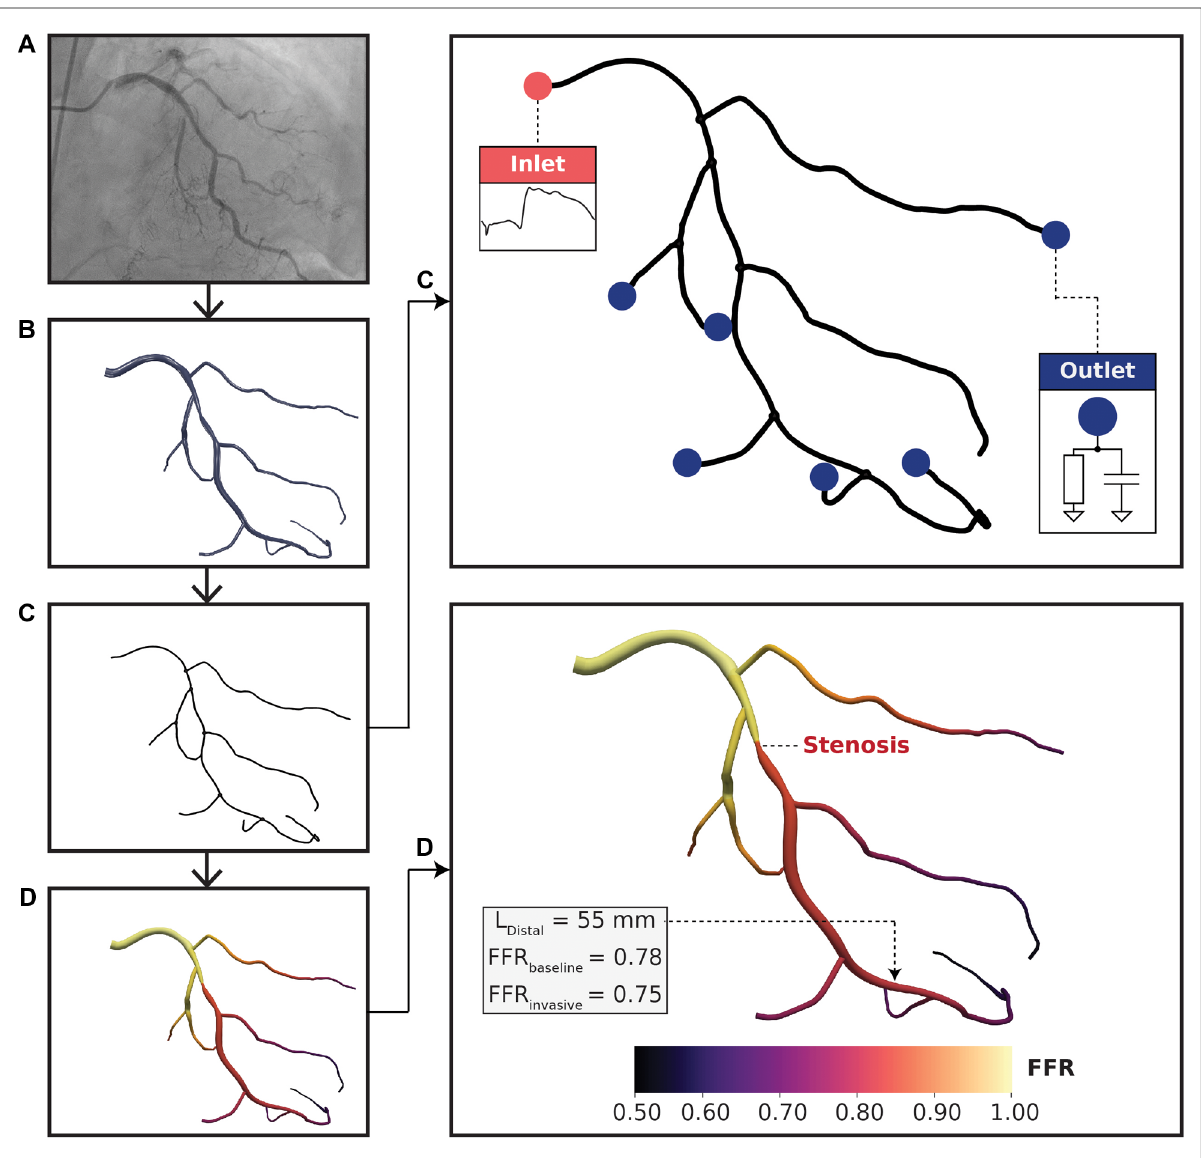
FIGURE 1 Computational fl uid dynamics modeling pipeline. ( A ) Coronary angiograms were acquired for each patient. At least 4 or 2 standard orthogonal views were collected for left and right coronary trees, respectively. ( B ) A three-dimensional (3D) arterial tree model was semi-automatically reconstructed using a pair of coronary angiograms. ( C ) Vessel centerlines were extracted from the 3D reconstructed geometry for one-dimensional (1D) simulation. Pulsatile fl ow rate was used at the inlet boundary condition and 2-element Windkessel models were used at the outlet boundary conditions. The lumped parameter models consisted of resistance-compliance components, where resistances were related to terminal vessel anatomy. ( D ) FFR results mapped on a left coronary vessel. The distal location (L Distal ) was labeled by an expert physician and was situated 55mm downstream to the distal-end of the stenosis. FFR baseline and FFR invasive resulted in the same FFR classi fi cation with minimal